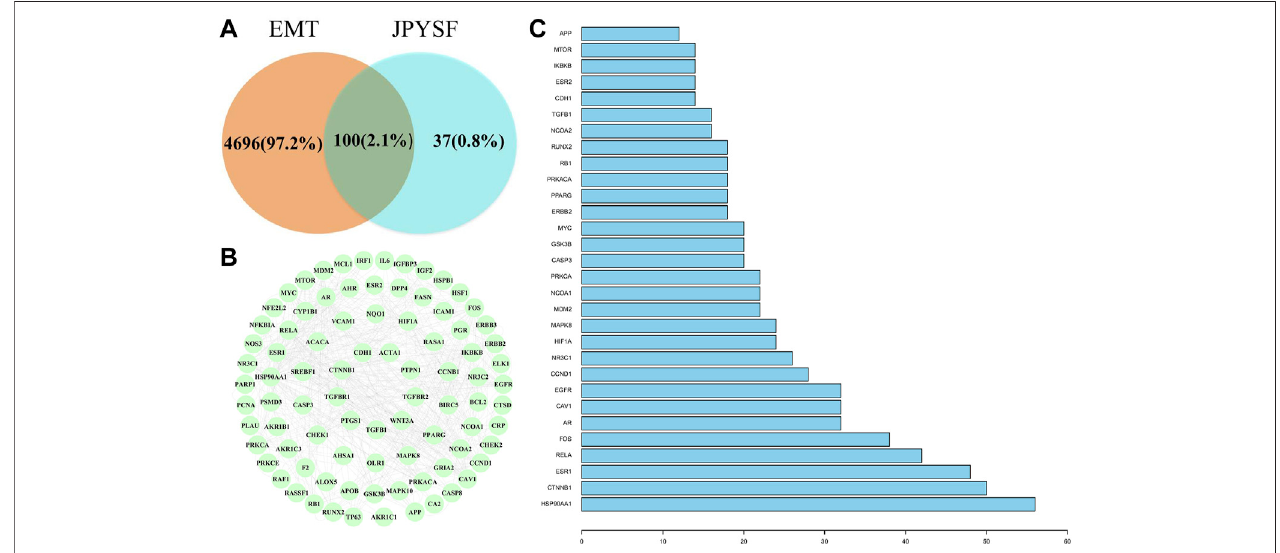
FIGURE 1 | The interaction of shared targets between Jian-Pi-Yi-Shen formula (JPYSF) active ingredients and epithelial – mesenchymal transition (EMT). (A) . The Venn diagram; (B) 87 connected nodes in the network; and (C) The top 30 targets in action frequency.